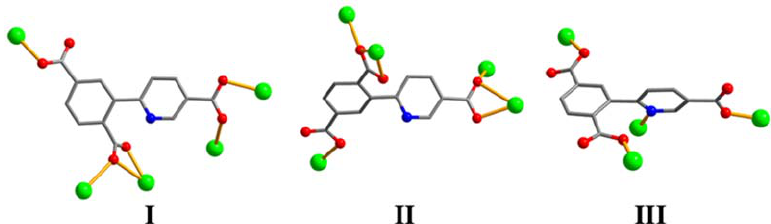
Scheme 1. Various coordination modes of cpta 3 − blocks in 1 (modes I, II) and 2 (mode III).